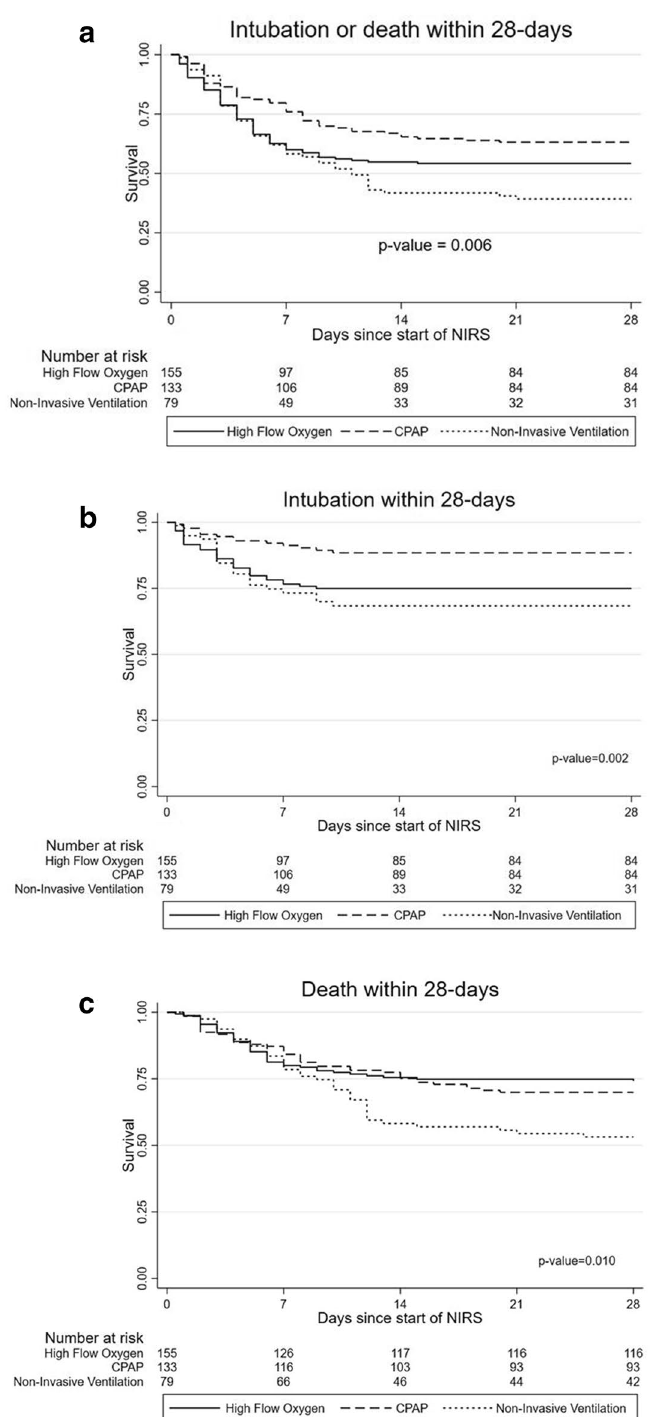
Figure 2. The 28-days Kaplan Meier curves from: ( a ) day starting NIRS to death or intubation; ( b ) day starting NIRS to intubation; and ( c ) day starting NIRS to death. NIRS non-invasive respiratory